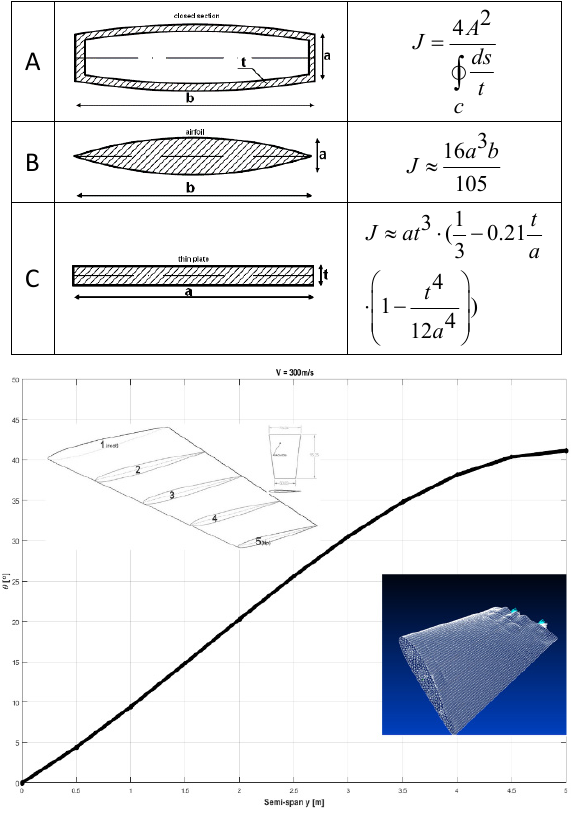
Figure 5. Sectional rotational field Assuming small rotations, the angle θ is approximately equal to the tangent of the angle, which is equal to the sum of the displacements, Δ l and Δ 2, divided by the chord distance apart (Figure 6).